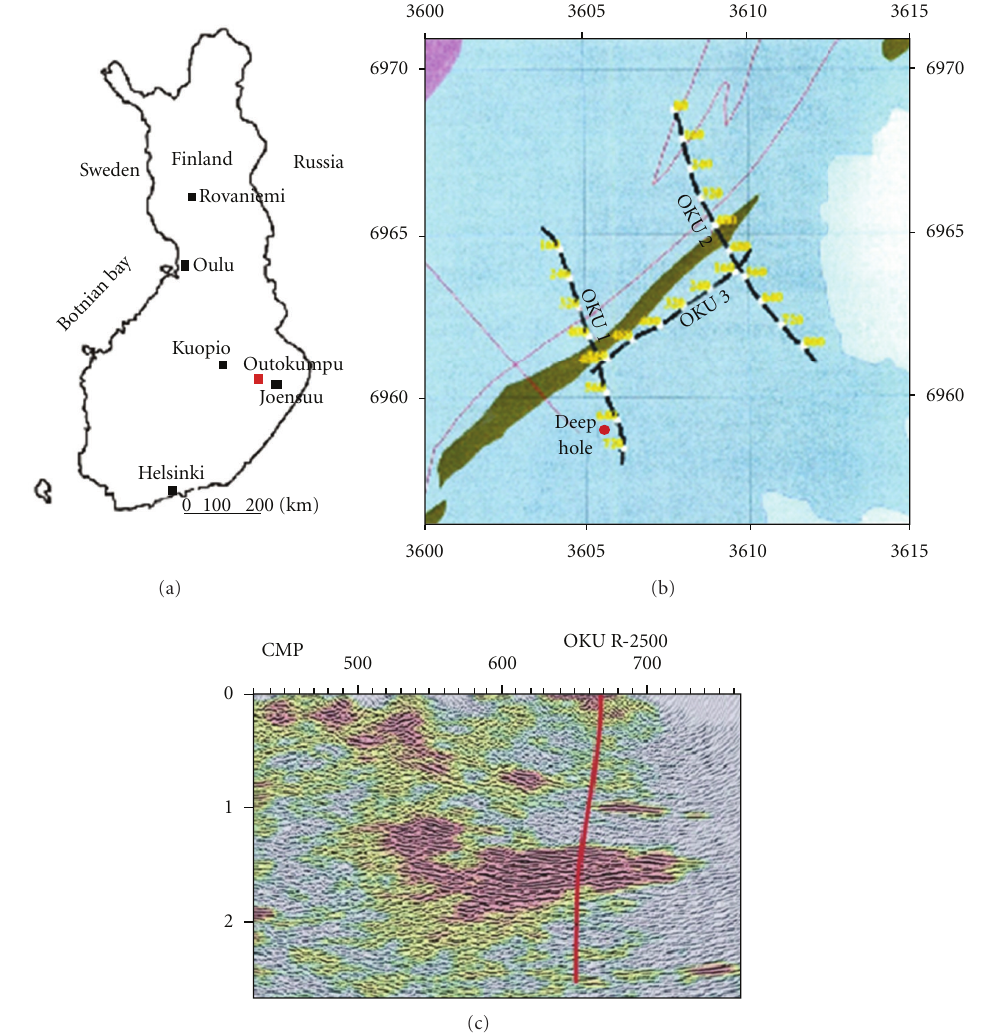
Figure 3: Location of the Outokumpu scientific drill hole (a), along with high-resolution reflection lines (b) and the end of the migrated OKU-1 section at Outokumpu (c) (after Heikkinen et al. [20] and Kukkonen et al. [21]